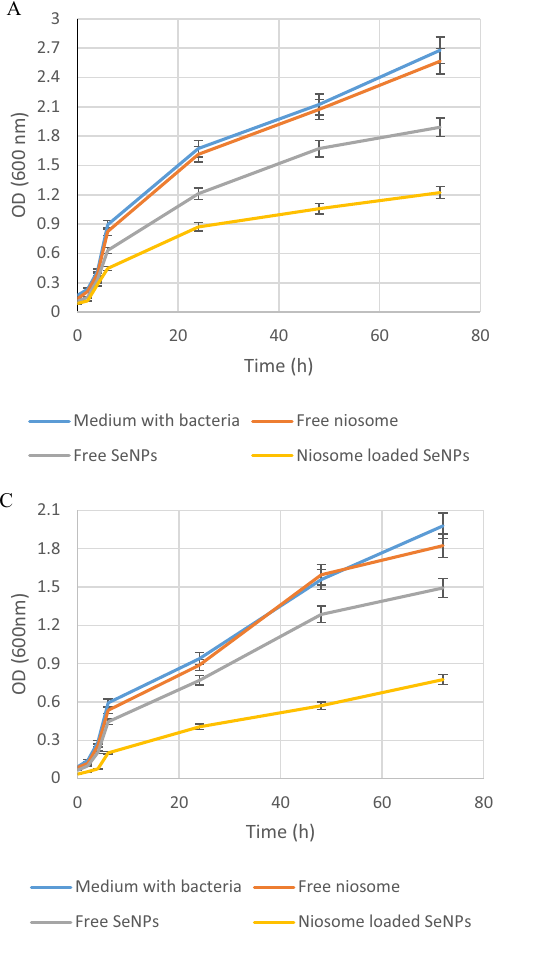
Figure 4. Antibacterial activity of free SeNPs and niosome loaded SeNPs against selected pathogenic bacteria including P. aeruginosa ( A ), E. coli ( B ), E. fecalis ( C ), and S. aureus ( D